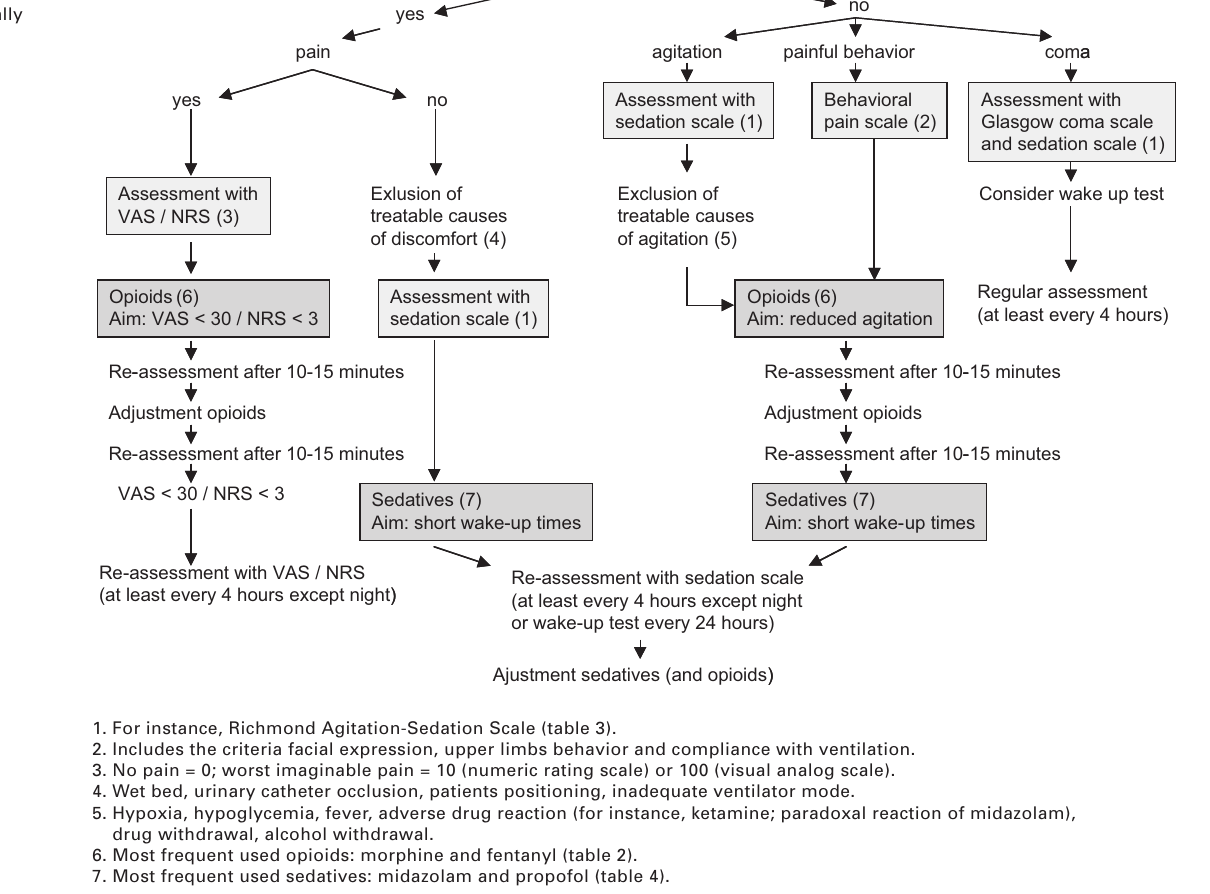
Decision tree for analgesia and se- dation in critically ill